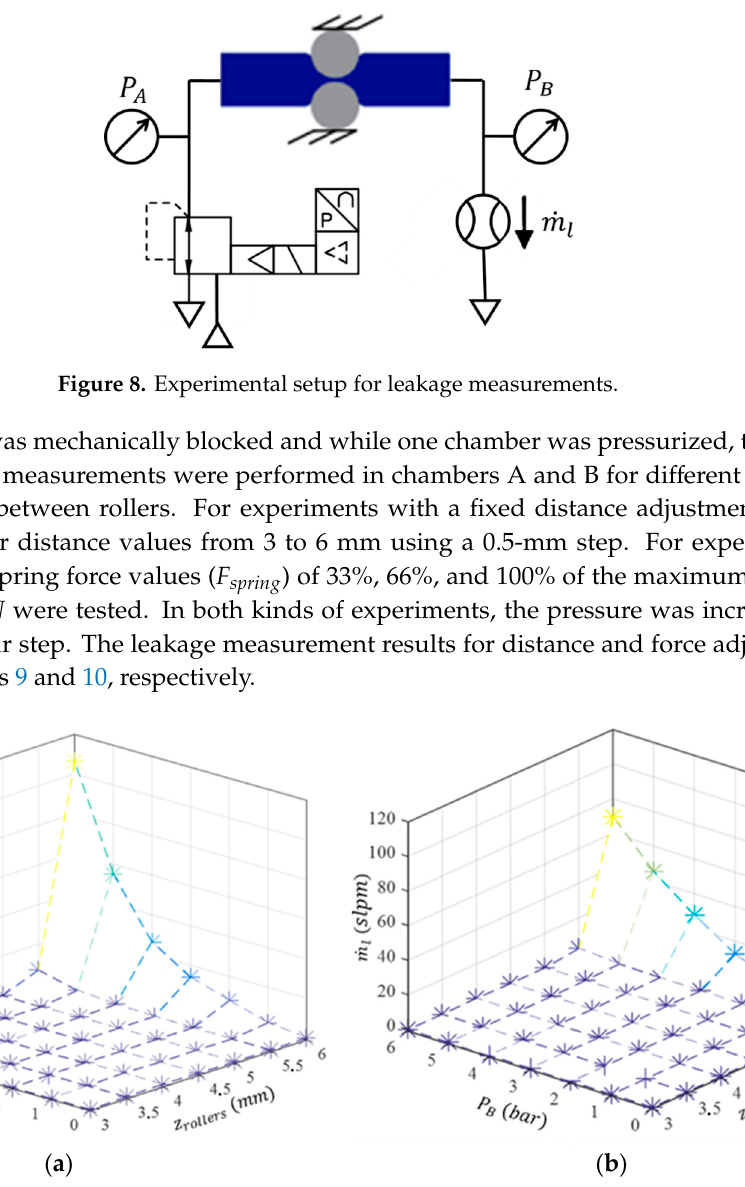
Figure 9. Leakage measurements with roller distance adjustment: ( a ) chamber A; ( b ) chamber B.